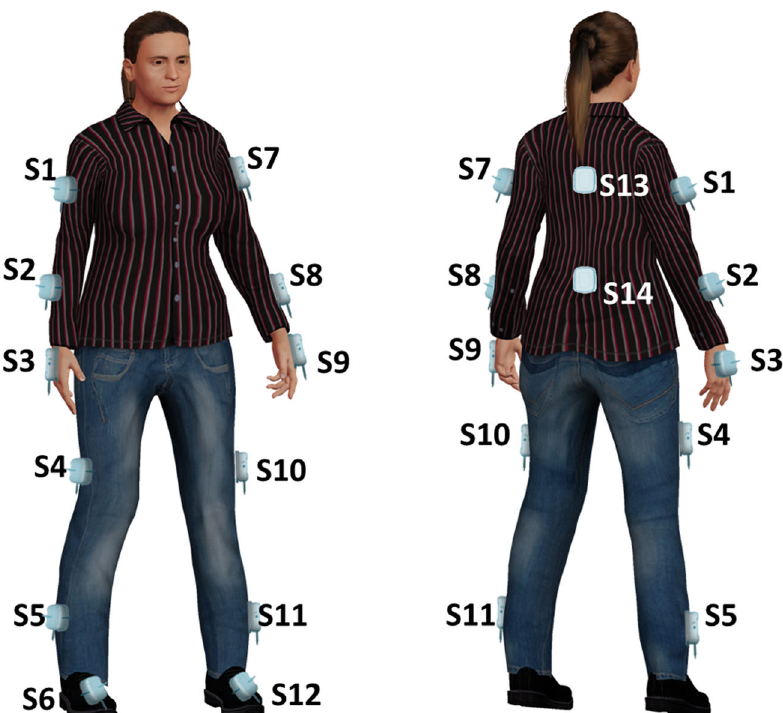
Fig. 2 Position of wearable sensors. For RT, PosT, and RAHM tasks S3 and S9 were analyzed. For LA S4 and S10, for TT S6 and S12. For PT we used S5, S11 ans S13. For TUG S1, S2, S4, S5, S7, S8, S10, S11, S13, and